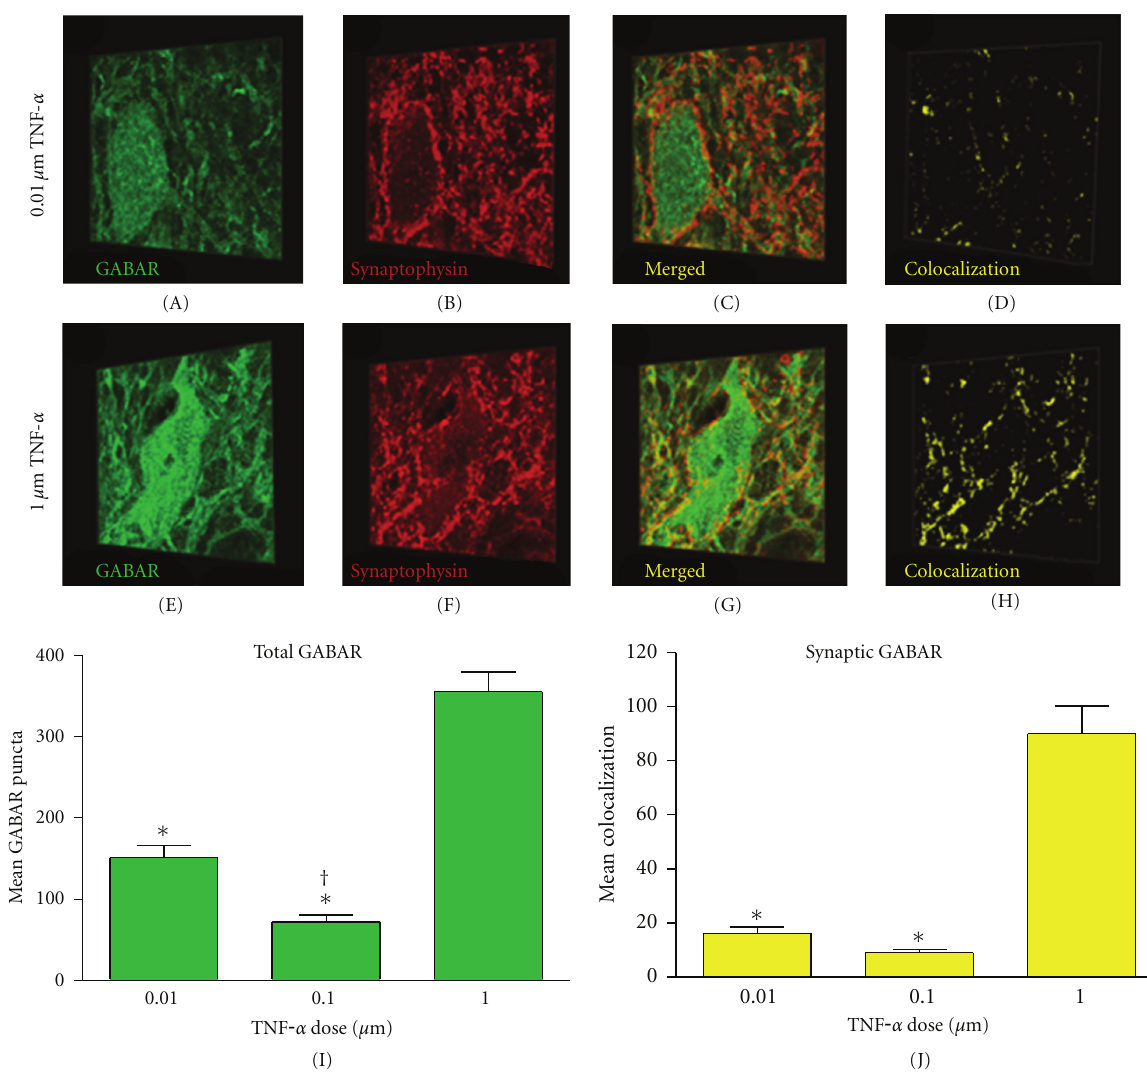
Figure 4: Increased synaptic GABA A R expression in the neuropil 60min after TNF α injection. (a)–(h) Three-dimensional representative images of motor neurons demonstrating a dose-dependent increase in synaptic GABA A Rs in the neuropil after TNF α injection. (i) Quantification of confocal stacks shows a significant increase in total GABA A Rs following the highest dose of TNF α ( ∗ P < 0 . 001 from middle and lowest doses). An increase in total GABA A Rs was also observed in the lowest dose relative to the middle dose ( † P = 0 . 015). (j) An increase in synaptic GABA A Rs occurred following the highest dose of TNF α ( ∗ P < 0 . 001 from middle and lowest doses). Bars represent group means across > 800 confocal image stacks (12 subjects, n = 4 subjects per group). Error bars reflect SEM. Scale bar, 30 μ